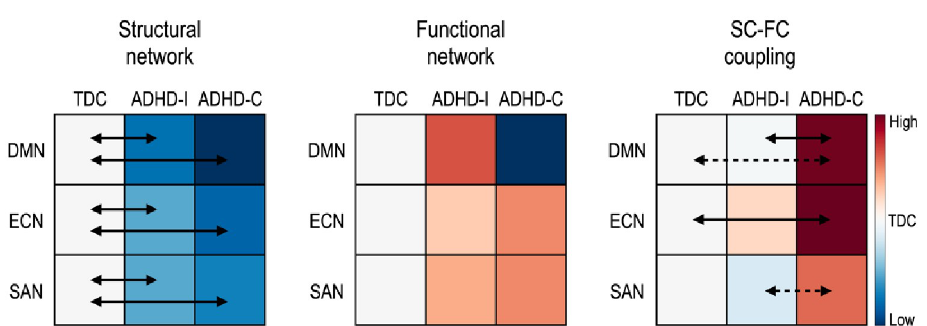
Fig 6. Summary of the global efficiency of both structural connectivity (SC) and functional connectivity (FC), and the SC-FC couplings in ADHD-related subnetworks. The solid arrow indicates significant group differences and the dotted arrow indicates a tendency of differences (if not significant) between groups. The colors indicate the group means of each feature relative to the TDC. Red indicates higher mean value while blue indicates lower mean value than TDC. DMN: default mode network, ECN: executive control network, and SAN: salience network.